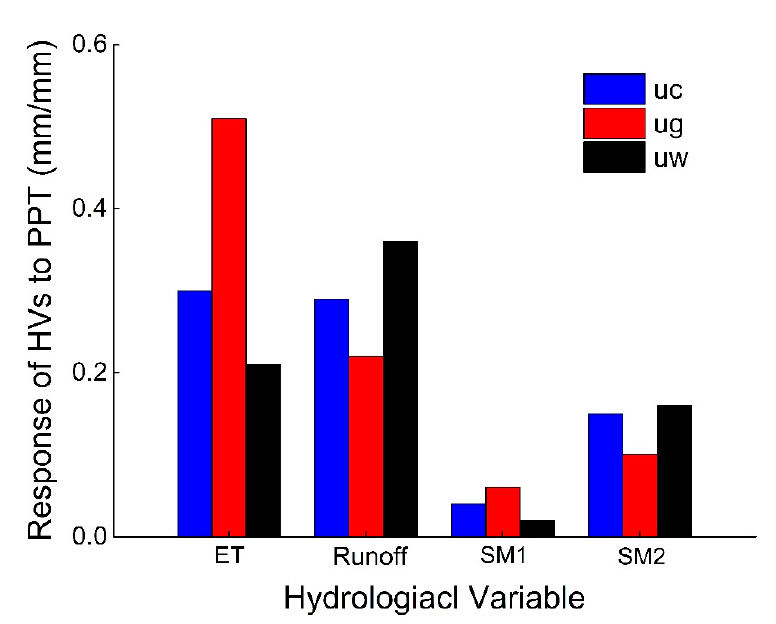
Figure 8. Response levels of the four key HVs to precipitation changes in three vegetation types.